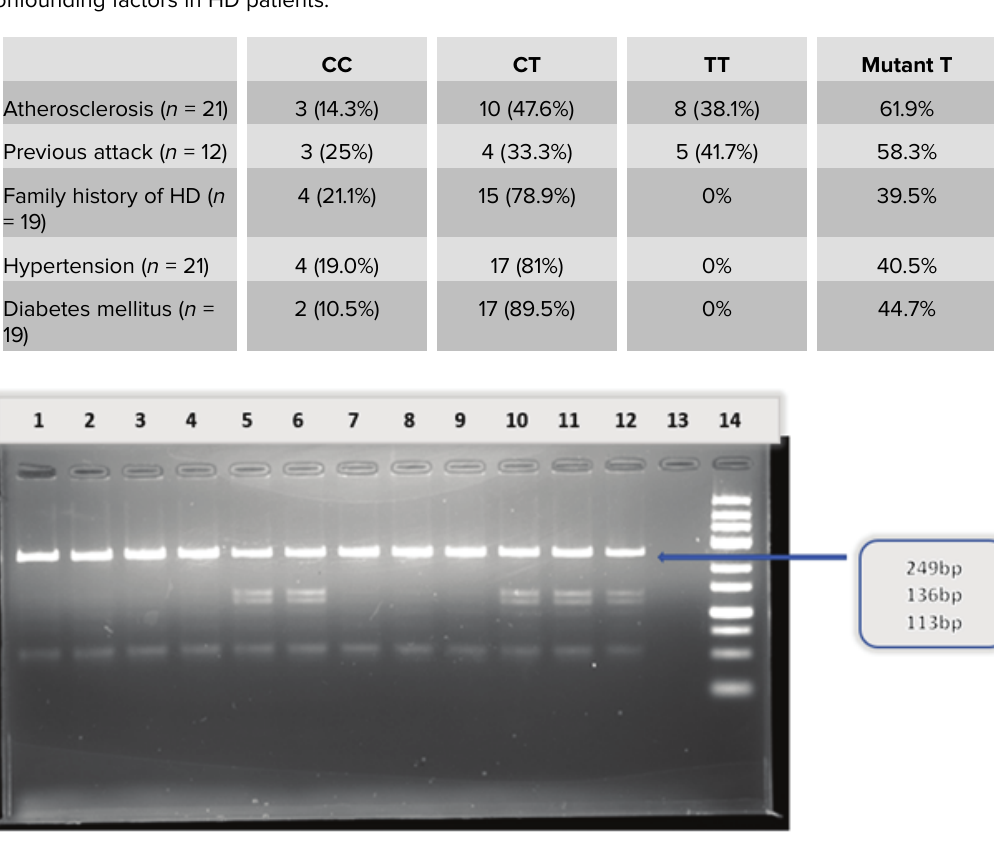
Figure 1: Lanes 1–4 and 7–9 are uncleaved wild-type homozygous CC (249 bp), lanes 5, 6, and 10–12 are heterozygous CT mutant (249, 136, 113 bp), lane 13 is negative control, and lane 14 represents the 25 bp DNA